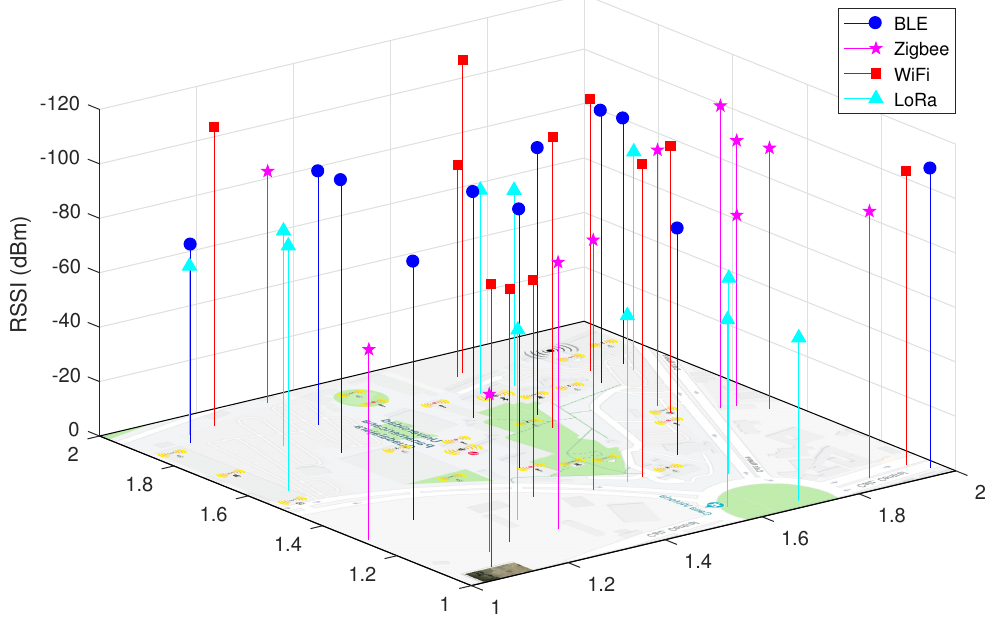
Figure 9. RSSI values in dBm under collaboration scheme for each